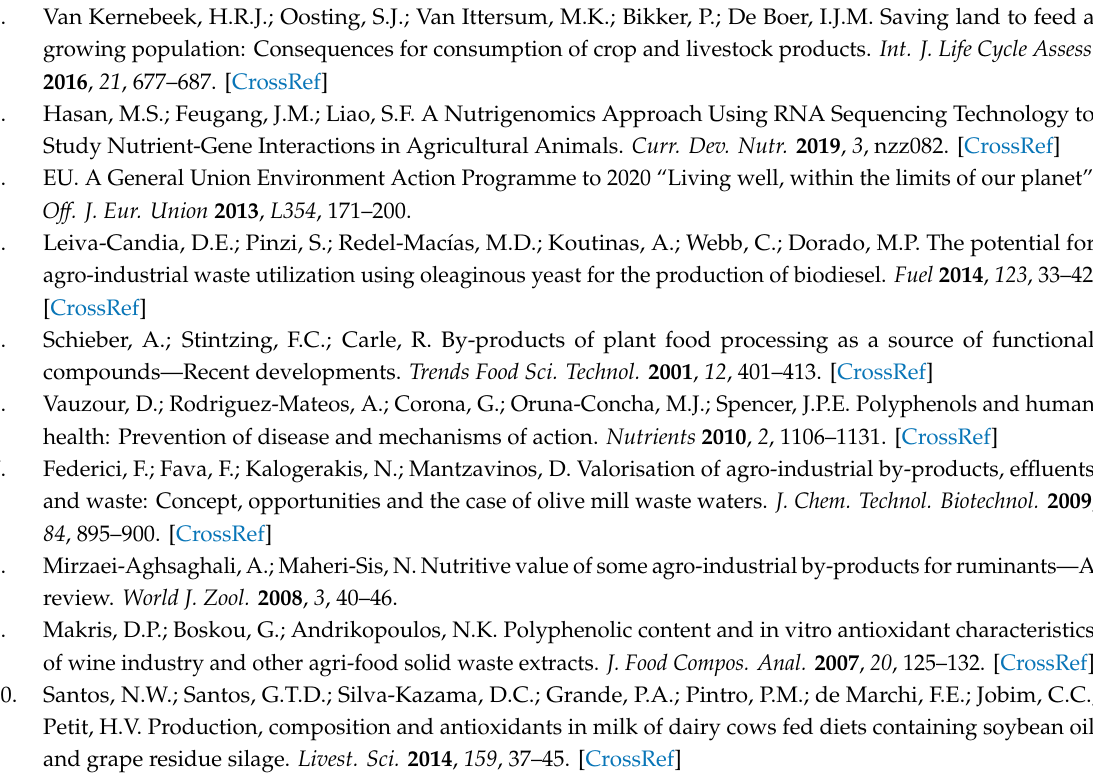
Figure S1. E ff ects of dietary GP supplementation on milk production. Table S1. Sequencing and alignment summary. Table S2. Di ff erentially Expressed Genes (DEGs). Table S3. Summary of the GSEA analysis